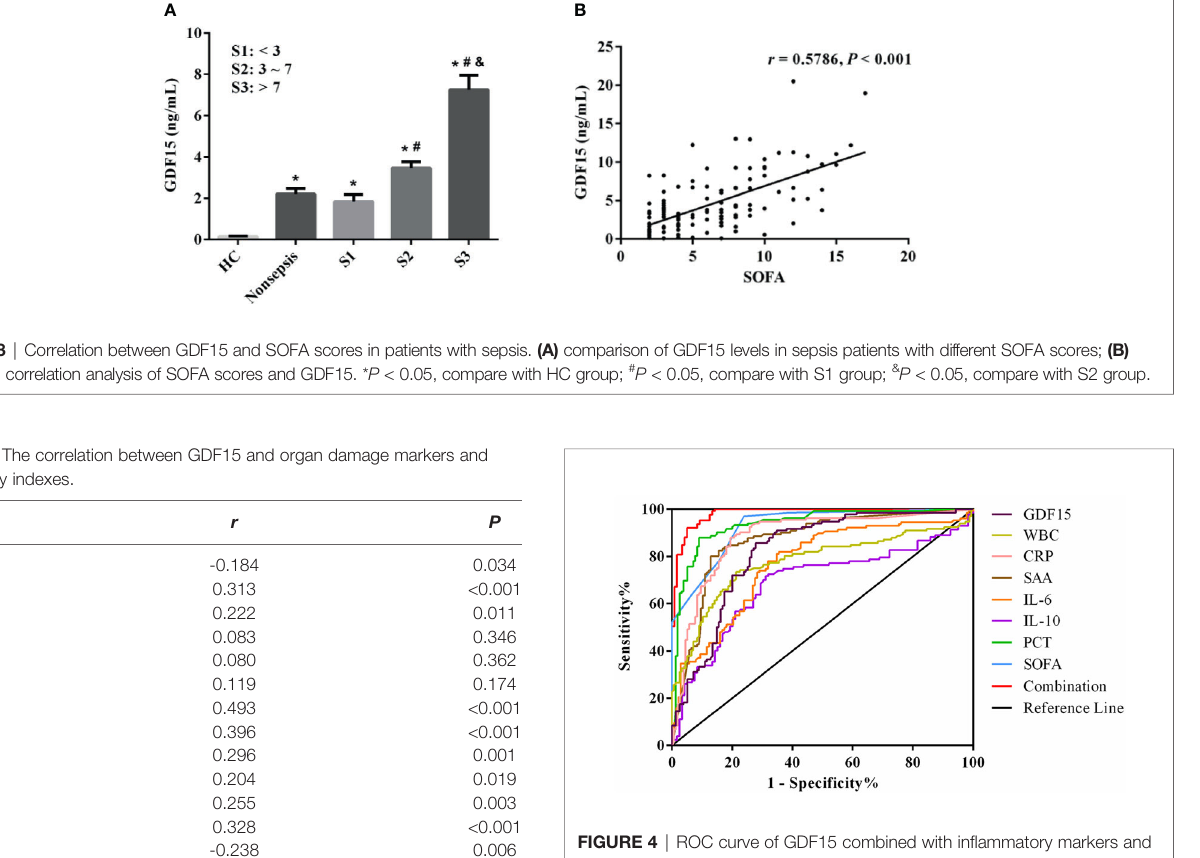
FIGURE 4 | ROC curve of GDF15 combined with in fl ammatory markers and SOFA in diagnosis of